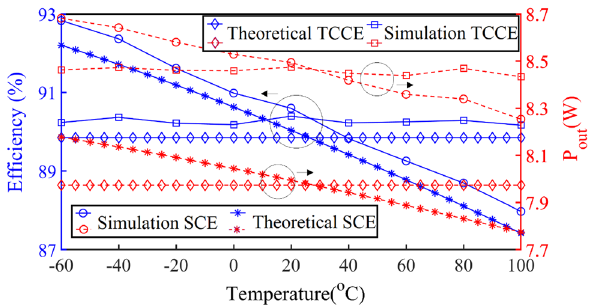
Figure 21. The changes in efficiency and output power of the SCE and TCCE.